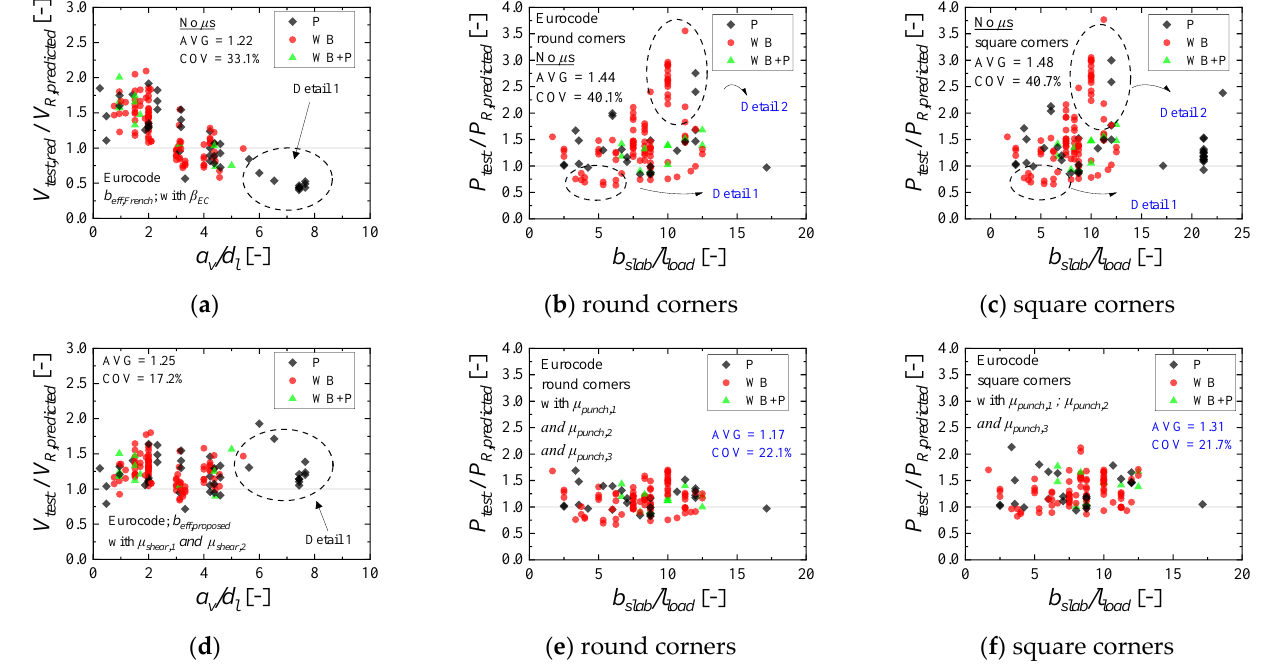
Figure 17. Comparison between tested and predicted resistances the European code expressions for: ( a ) one-way shear and without the correction factors µ ; ( b ) punching shear, without the correction factors µ , and using round corners for the control perimeter; ( c ) punching shear, without the correction factors µ , and using square corners for the control perimeter; ( d ) one-way shear with the correction factor µ ; ( e ) punching shear expressions, with the correction factors, and using round corners for the control perimeter; ( f ) punching shear expressions, with the correction factors µ s, and using square corners for the control perimeter. Note: P = punching failure; WB = wide-beam shear failure in one-way shear; WB + P = mixed mode between one-way shear and punching.